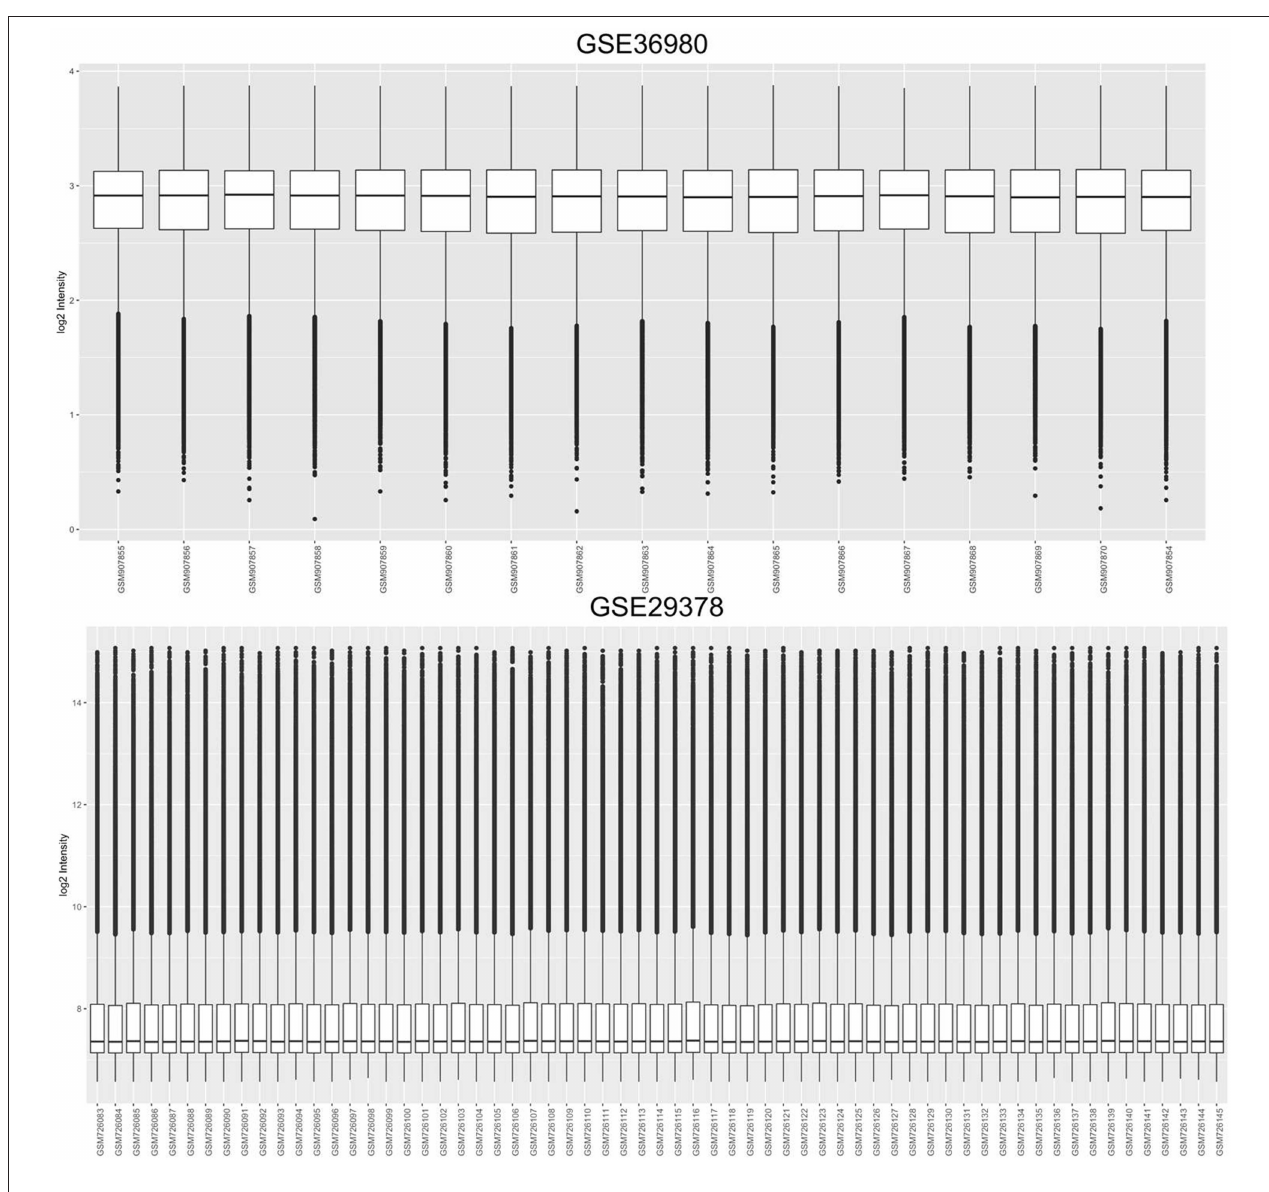
FIGURE 2 | Cassette figures of the expression data after standardization.